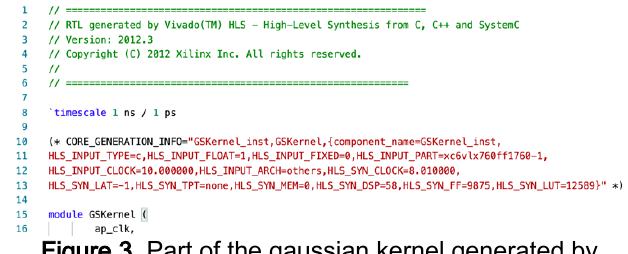
Figure 3. Part of the gaussian kernel generated by Vivado HLS